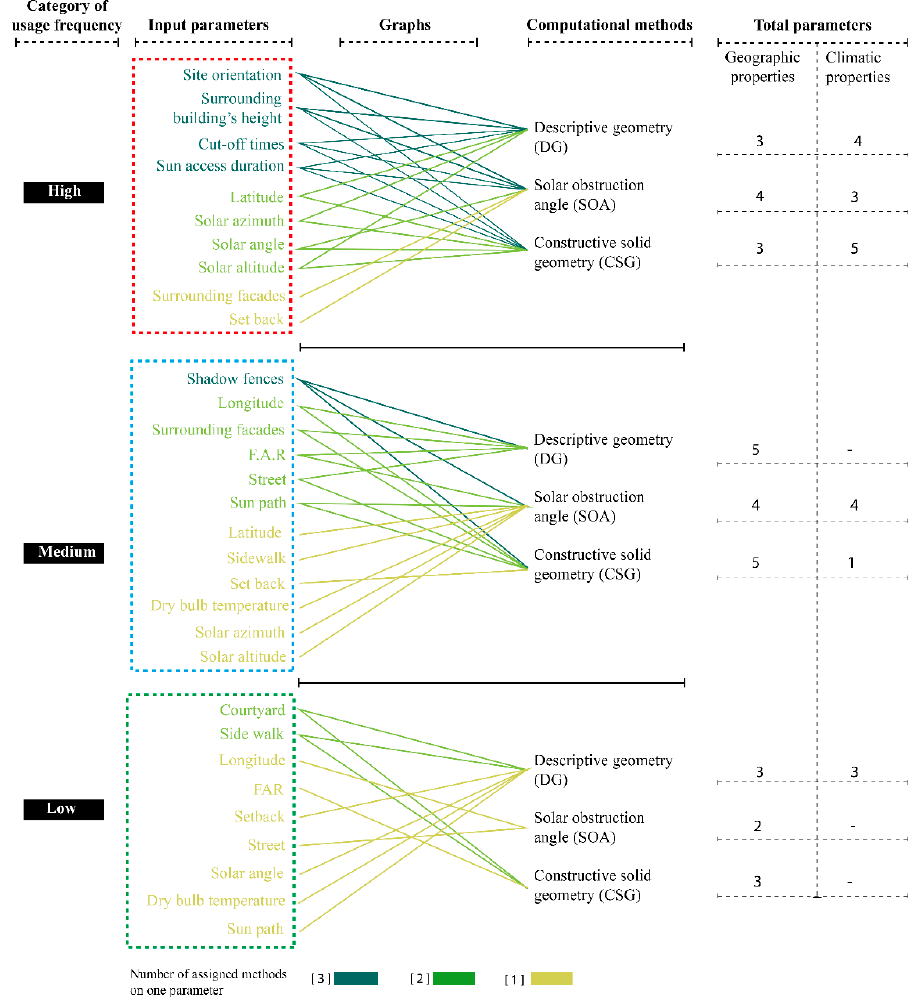
Figure 4. Specific distribution of design parameters (geographic and climatic properties) based on the group usage frequency and corresponding methods.